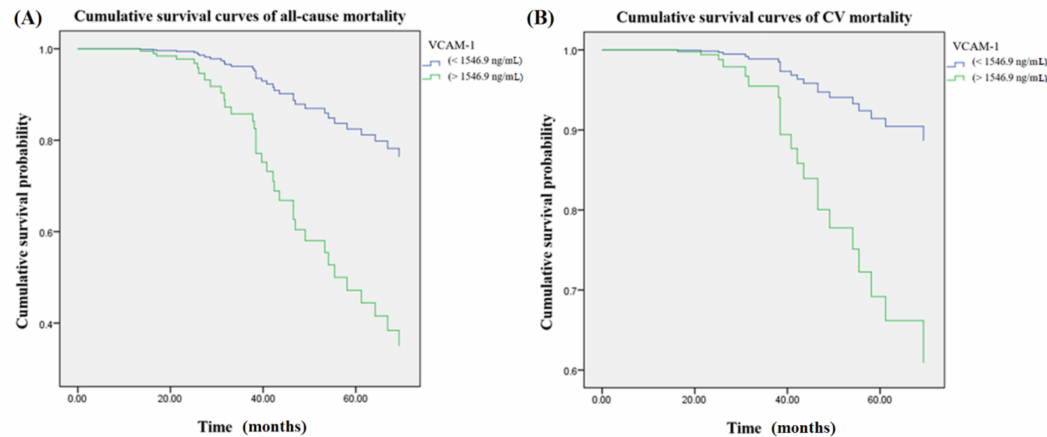
Figure 2. Cumulative survival curves of mortality risks with respect to serum concentrations of VCAM-1 after adjusting for galectin-3, VCAM-1, albumin, age, CRP, nPCR, and smoking during follow-up. ( A ) There was an association between higher VCAM-1 concentrations (>1546.9 ng/mL) and incremental risk of all-cause mortality. ( B ) The association between higher VCAM-1 concentrations and CV mortality remained robust after multivariable adjustment. VCAM-1 = vascular cell adhesion molecule 1; CRP = C-reactive protein; nPCR = normalized protein catabolic